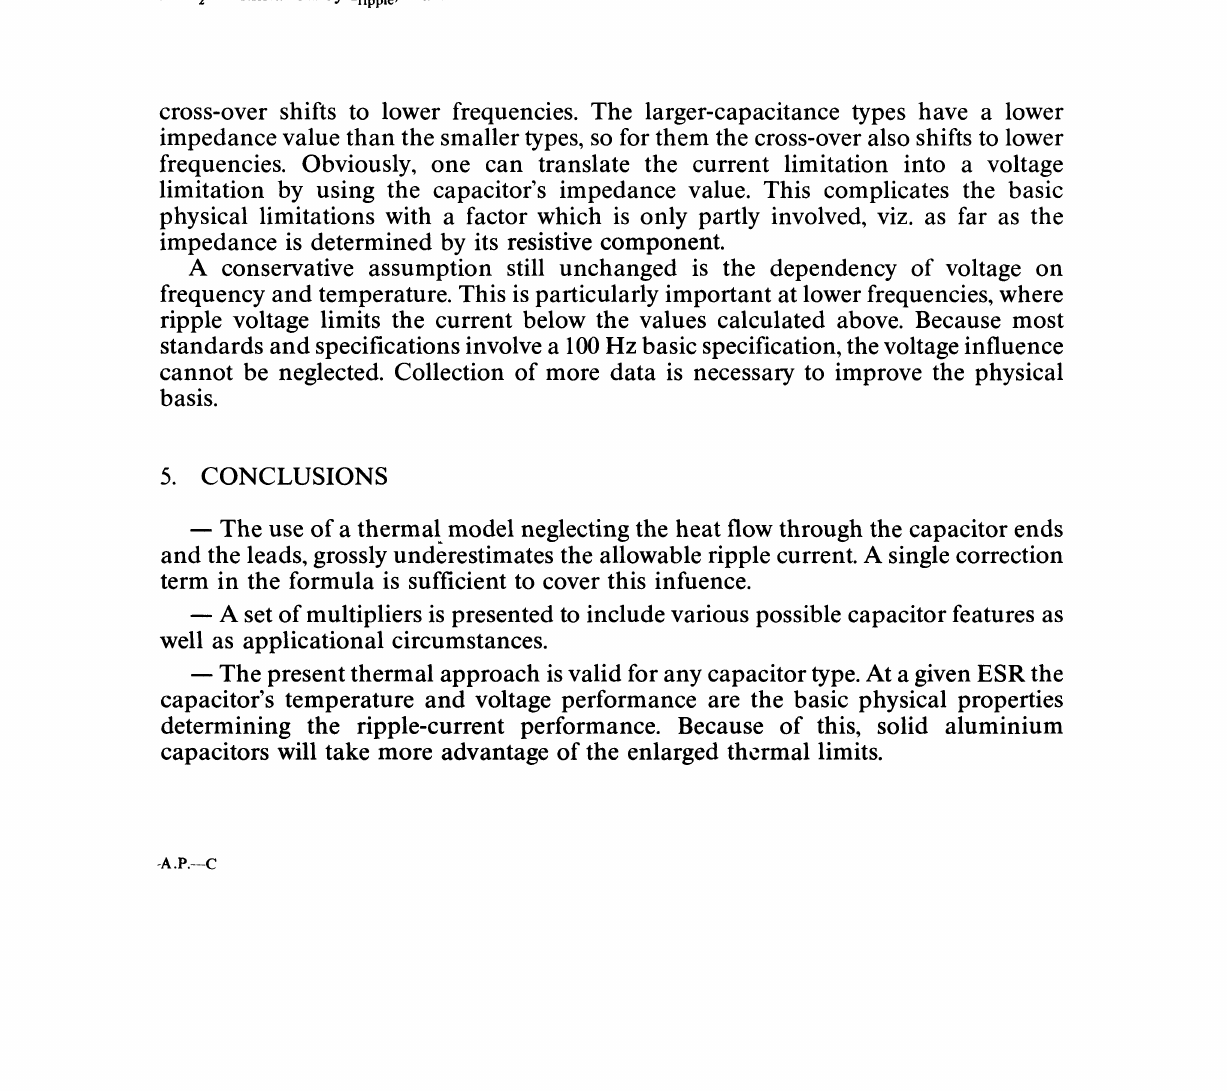
FIGURE 15 Interference of max ripple voltage U and max. ripple current I. Example: 100 #F-10V axial solid aluminium capacitor at 25C. f <